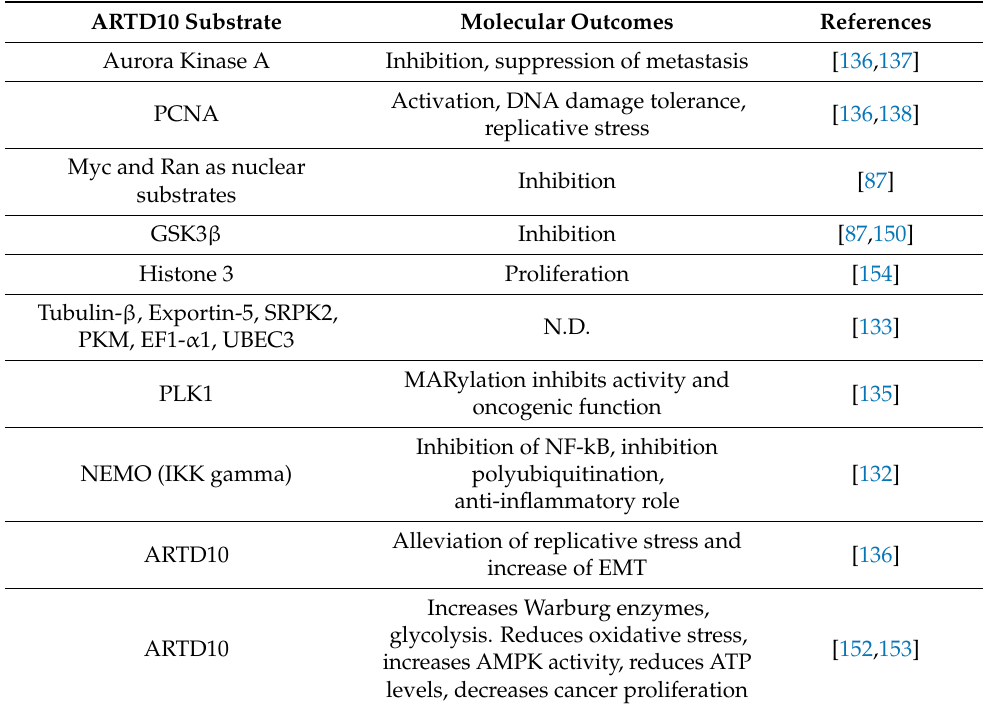
Table 2. Known substrates and biological roles of